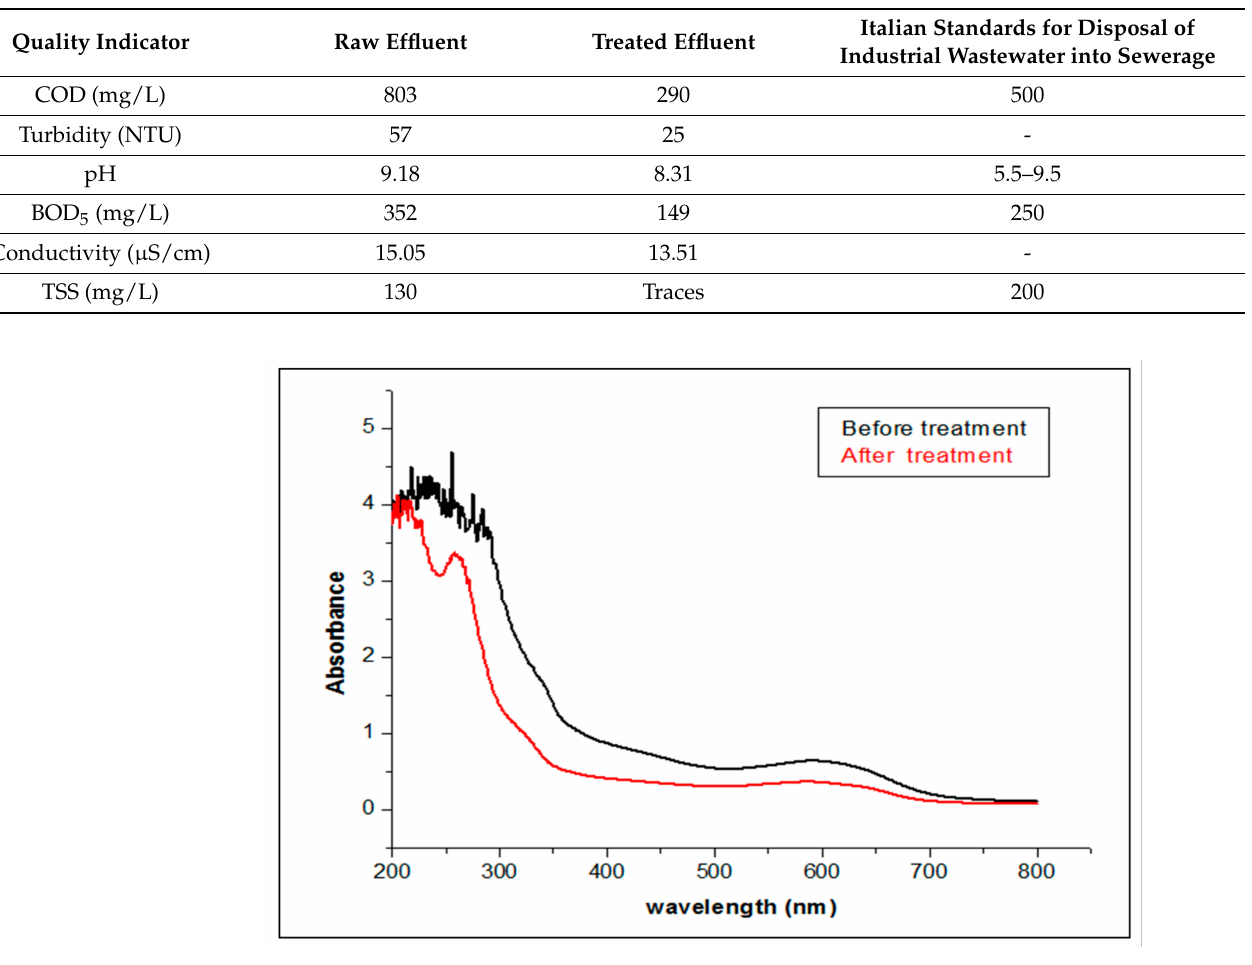
Figure 11. UV-Visible spectra of the real effluent at spontaneous pH before and after